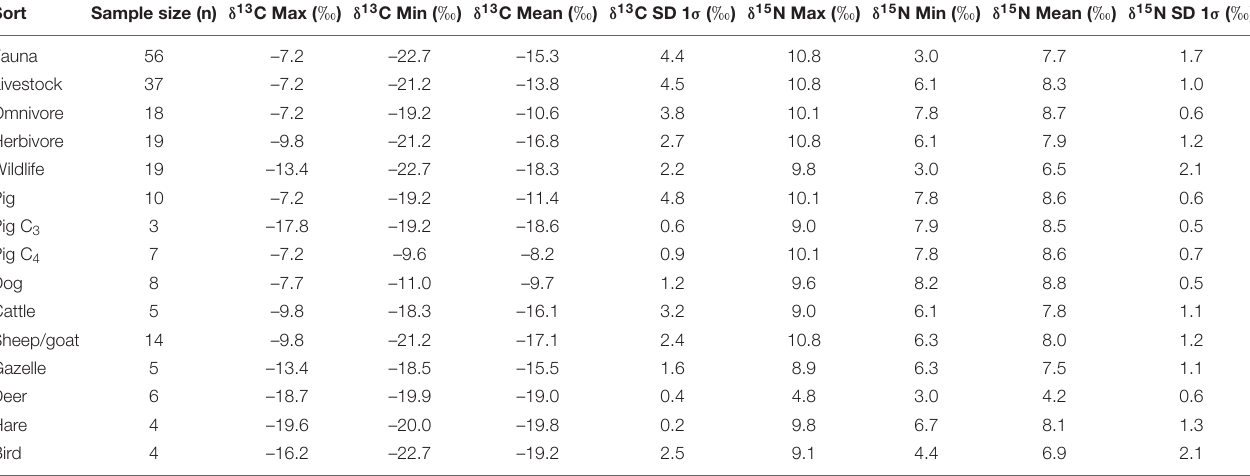
TABLE 2 | Statistics of stable carbon and nitrogen isotope data reported in this study.